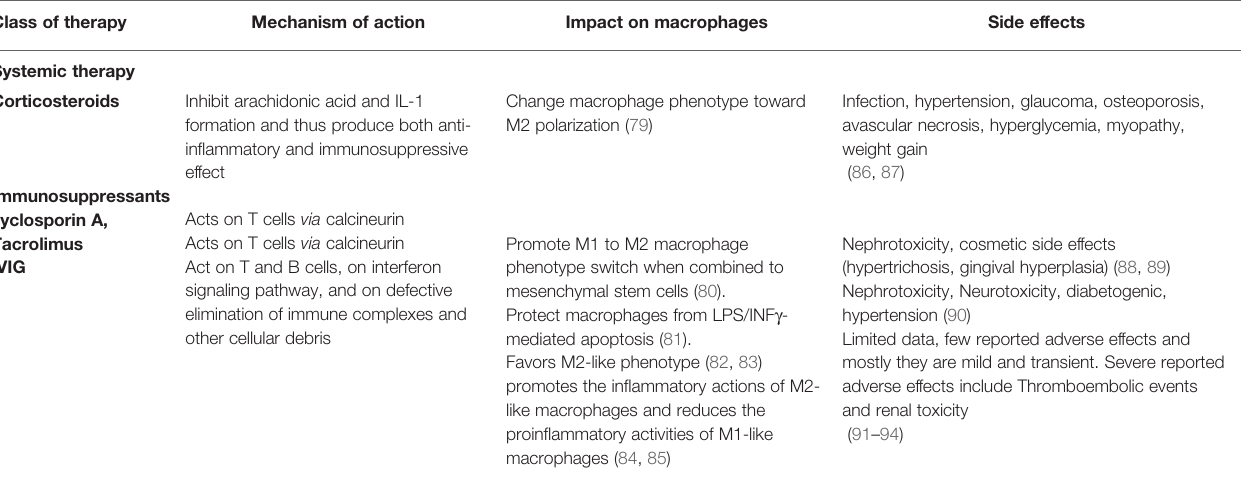
TABLE 2 | Current SLE medications with an impact on macrophage